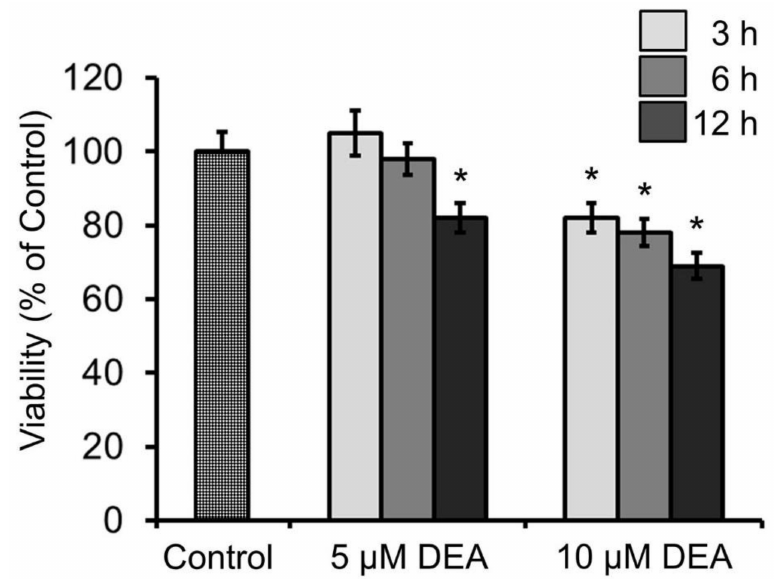
Figure 7. E ff ect of DEA on the viability of B16F10 melanoma cells. Cells were treated with 5 or 10 µ M of DEA for 3–12 h, and then the viability was determined using the SRB assay. The results are expressed as the % viability of the control (means ± SEM of five independent experiments). * indicates a significant di ff erence relative to the control ( p <